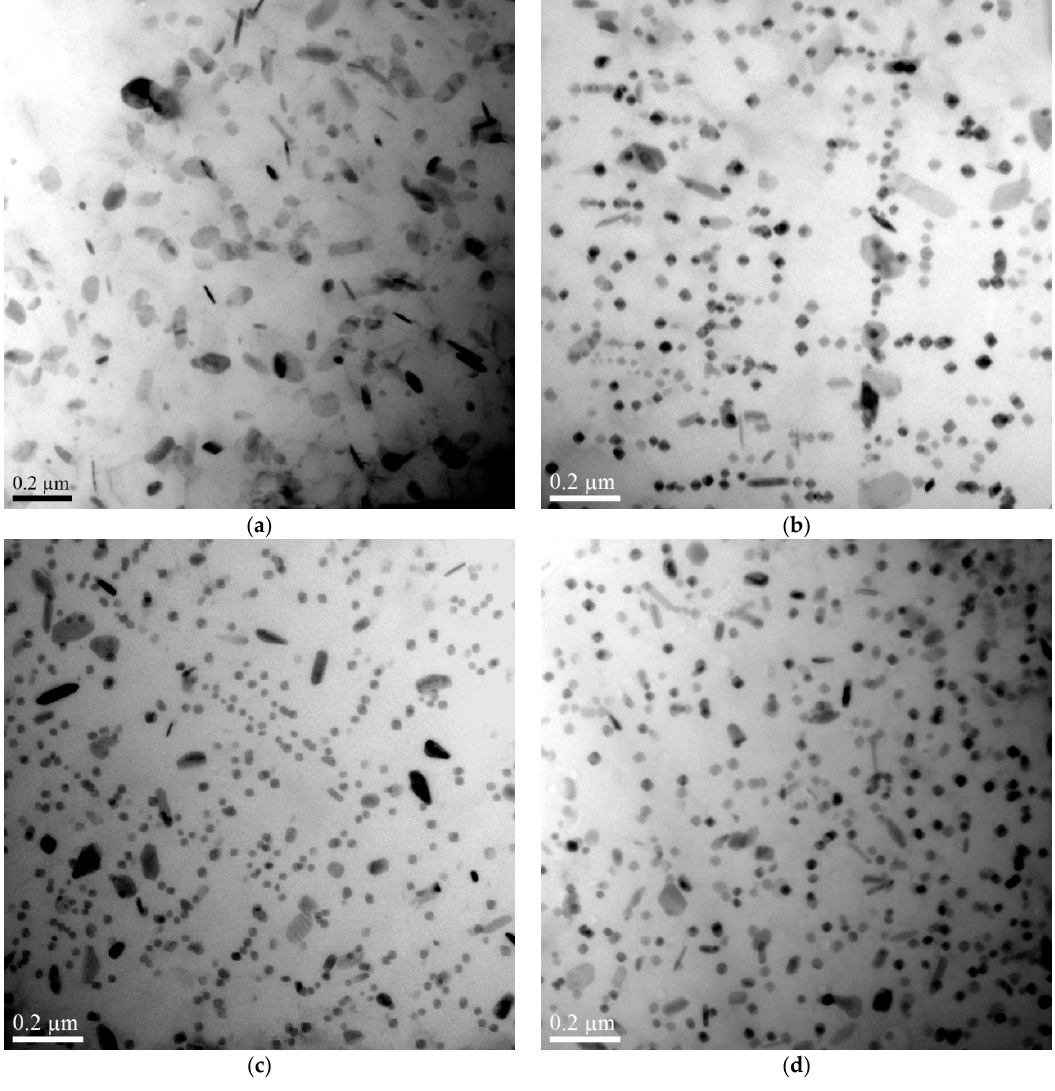
Figure 6. TEM (transmission electron microscope) bright field images of dispersoids after heat-treated at 425 °C for 6 h ( a ) DU0 alloy (0% Cu); ( b ) DU35 alloy (0.37% Cu); ( c ) DU75 alloy (0.72% Cu) and ( d ) DU120 alloy (1.23% Cu).